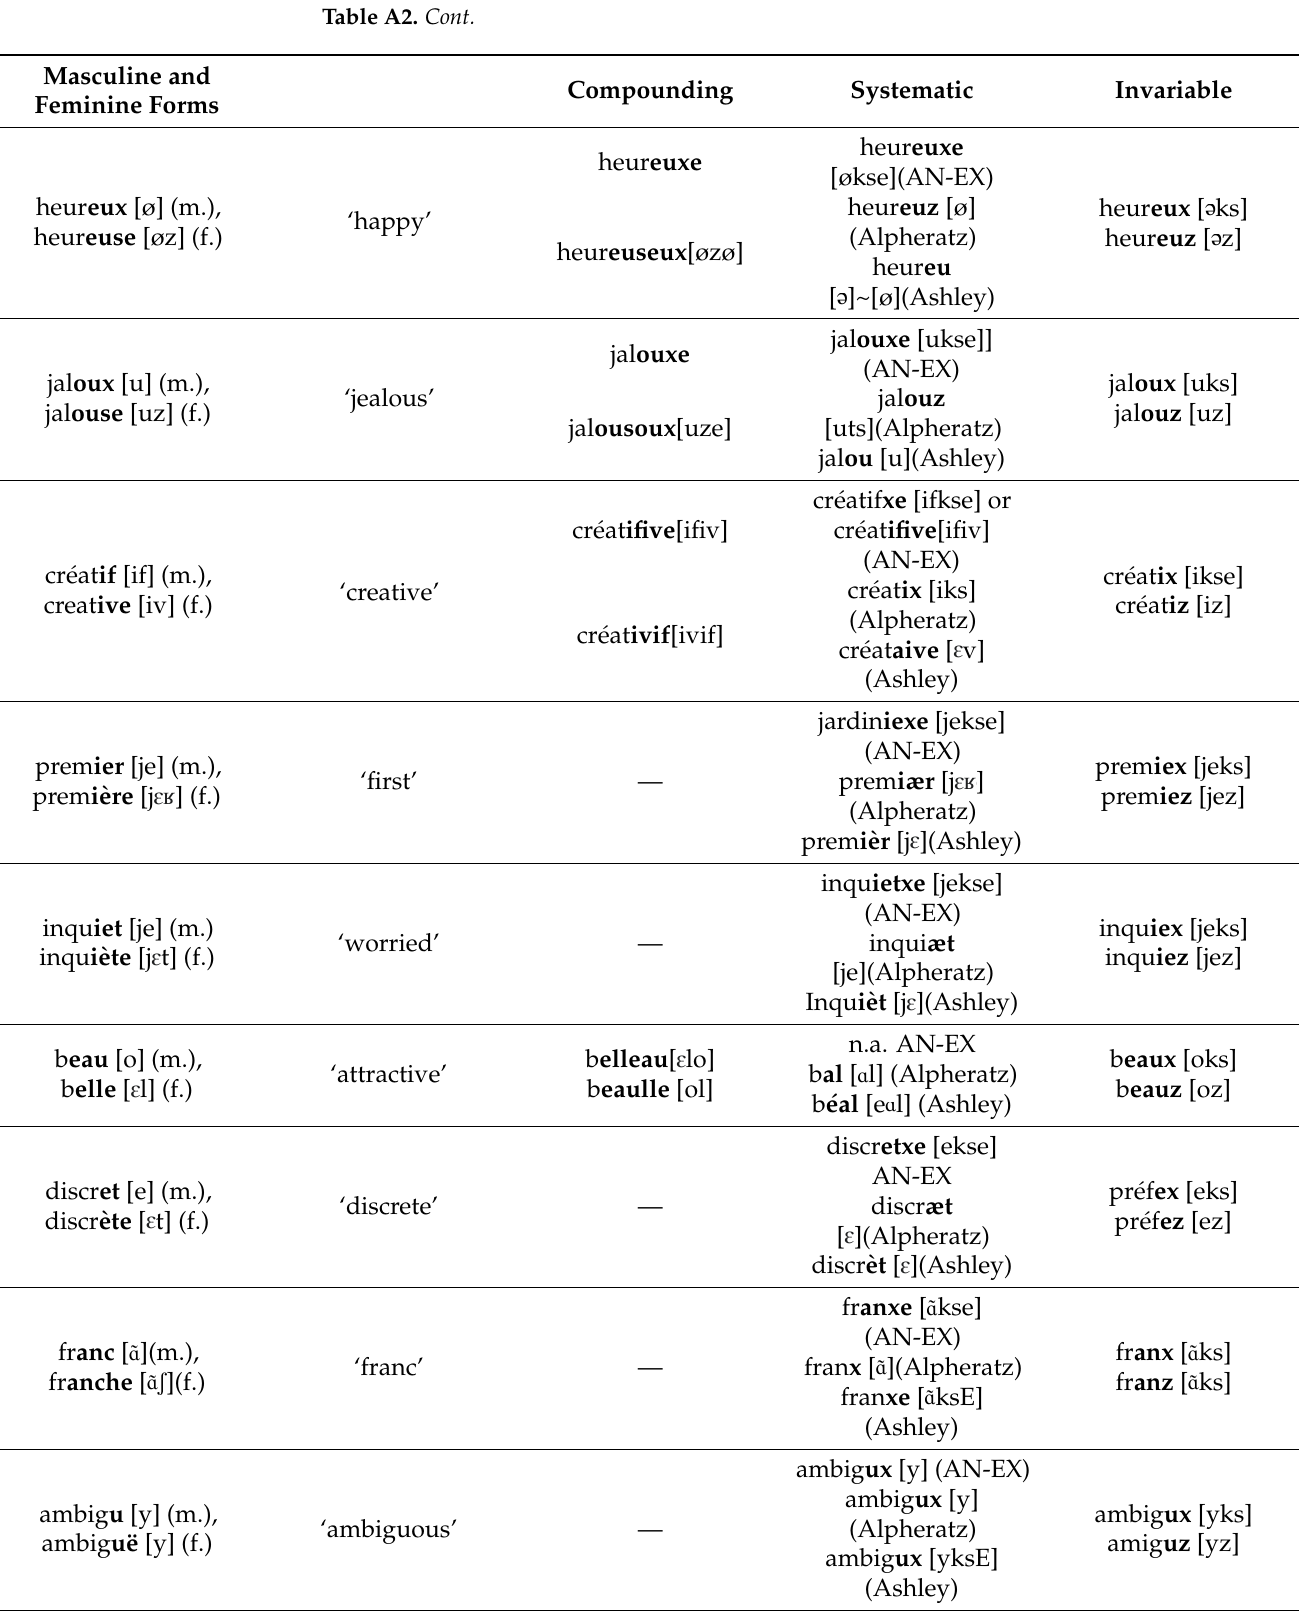
Masculine Feminine Masculine Feminine